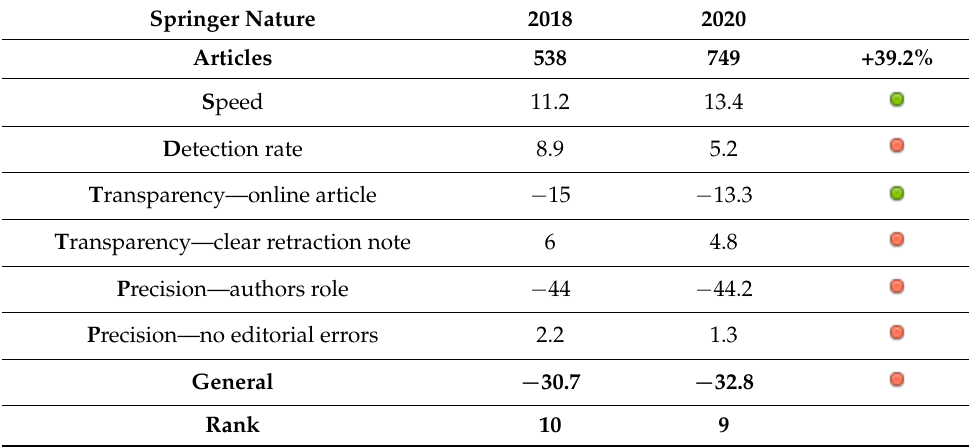
Table 16. Springer Nature 2018–2020 change of SDTP score. Table 15. Elsevier 2018 – 2020 change of SDTP score. Table 15. Elsevier 2018 – 2020 change of SDTP score.